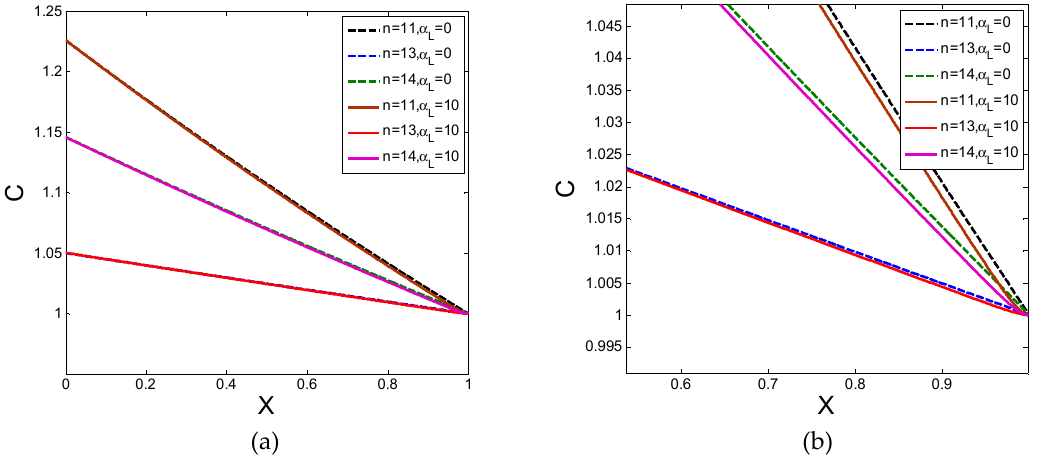
Figure 6. Concentration profiles of hydrocarbons for n = 11, 13, and 14 for path through the fault in G42: ( a ) profiles throughout the fault; ( b ) zoom near to production wells in the reservoir. Solid lines—flow with diffusion; dashed lines—diffusion-free flow.